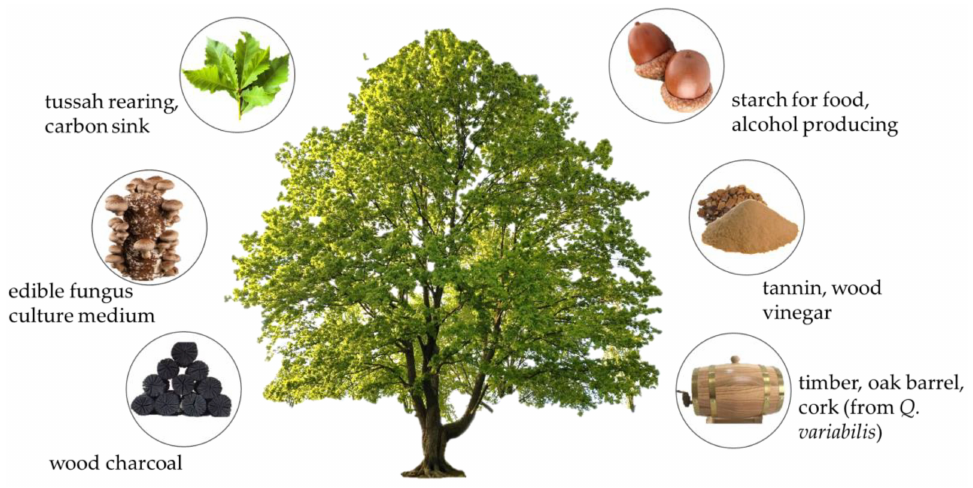
Figure 4. Various commercial products of oak trees in